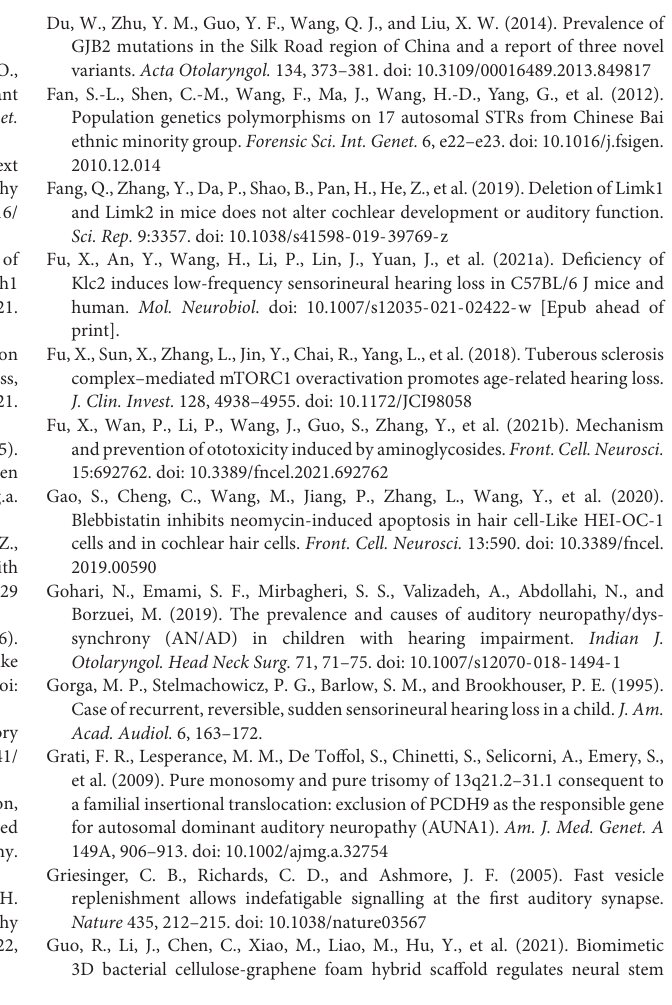
Supplementary Table 2 | Six mitochondrial deafness-related regions. Supplementary Table 3 | Three deafness-related miRNAs. Supplementary Table 4 | STR analysis of the affected twin brothers (II-3 and II-4). Supplementary Table 5 | Filtered variants of targeted NGS. Supplementary Table 6 | Likely pathogenic variants of targeted NGS. Supplementary Table 7 | Filtered variants of WES. Supplementary Table 8 | Likely pathogenic variants of